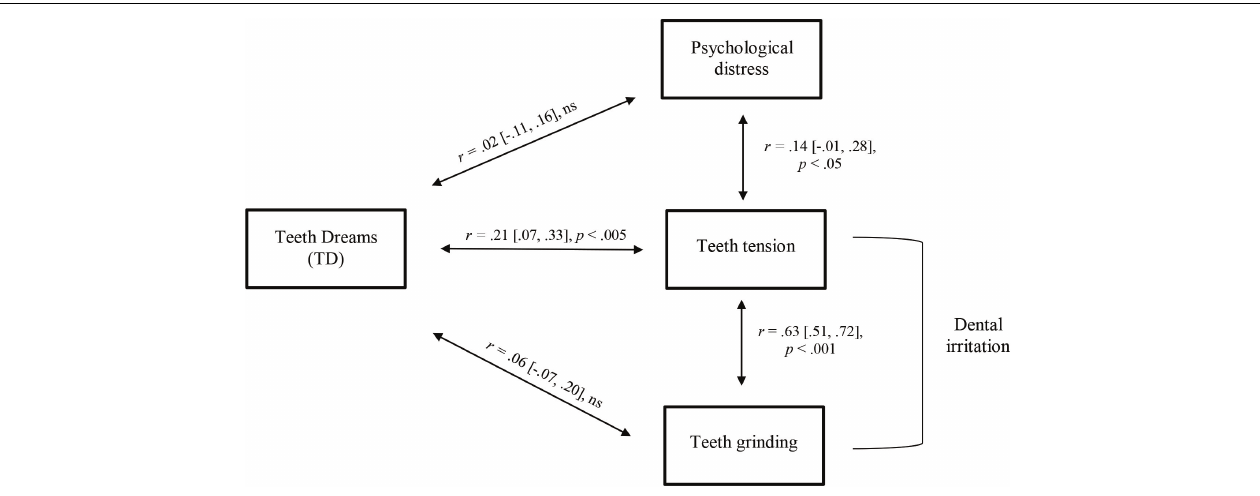
FIGURE 1 | A figure depicting the main results: rank-order correlation coefficients linking teeth dreams (TD) with dental irritation (teeth tension and teeth grinding) and psychological